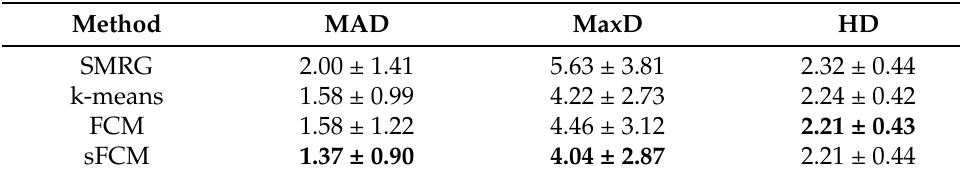
Table 5. Spatial distance-based metrics achieved by the proposed segmentation approaches: the results are expressed as average value ± standard deviation.